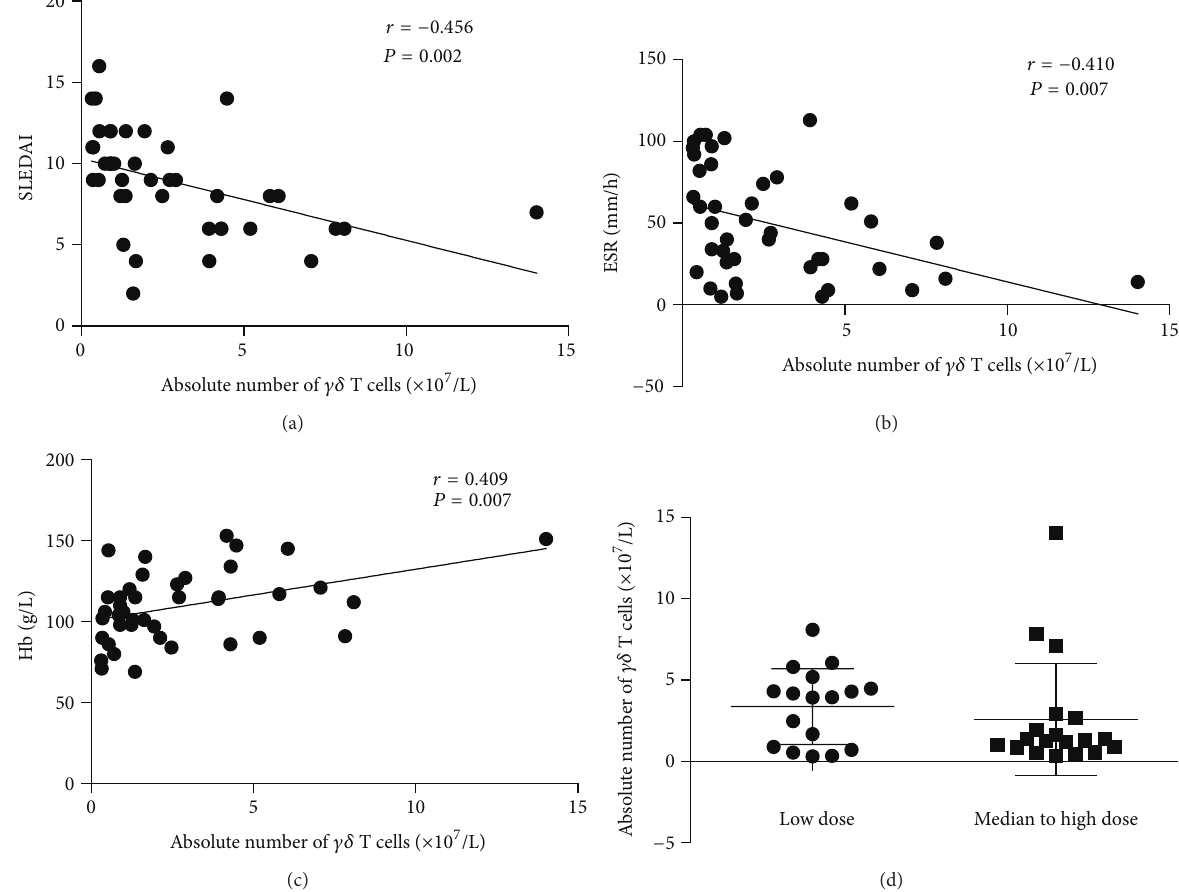
Figure 2: Associations of peripheral 𝛾𝛿 T cells with SLEDAI, ESR, Hb, and prednisone dosage in SLE patients. (a) Correlation of the absolute number of peripheral 𝛾𝛿 T cells with SLEDAI; (b) correlation of the absolute number of peripheral 𝛾𝛿 T cells with ESR; (c) correlation of the absolute number of peripheral 𝛾𝛿 T cells with serum hemoglobin level; (d), comparison of the percentage and absolute number of peripheral 𝛾𝛿 T cells with different doses of